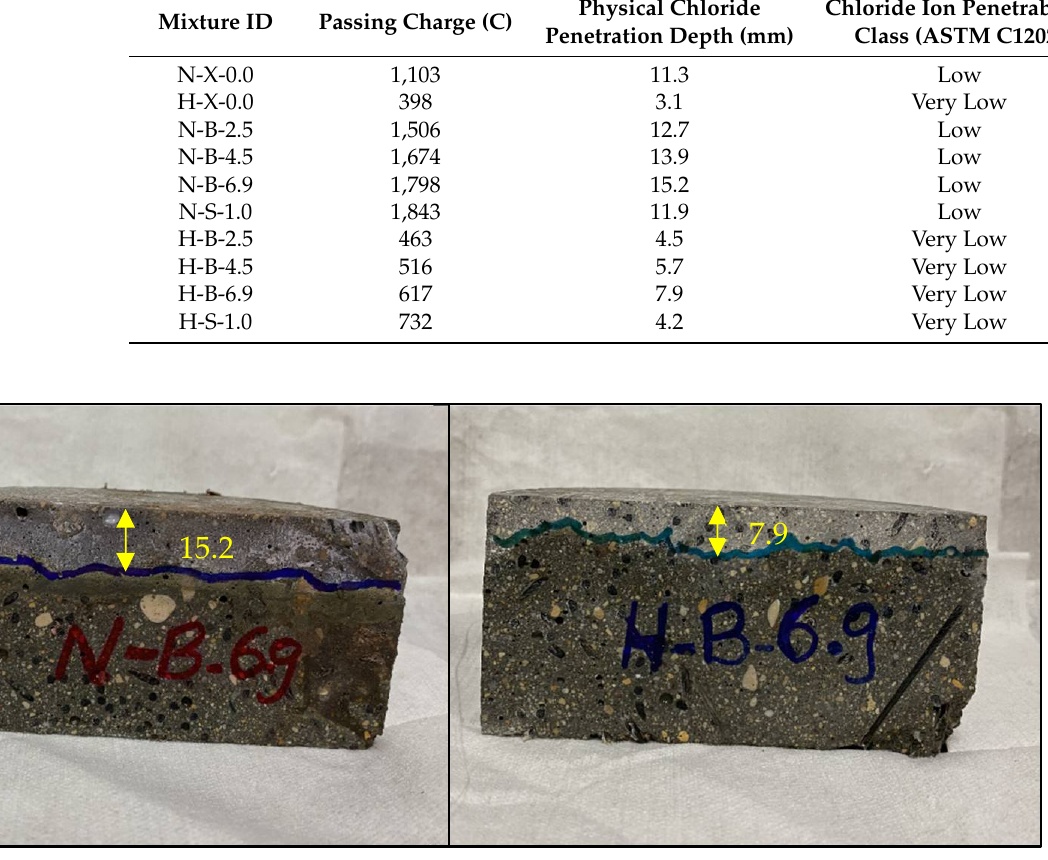
Figure 10. Whitish precipitate indicating the penetration depth of chloride ions into the N-B- 6.9 and H-B-6.9 composites.